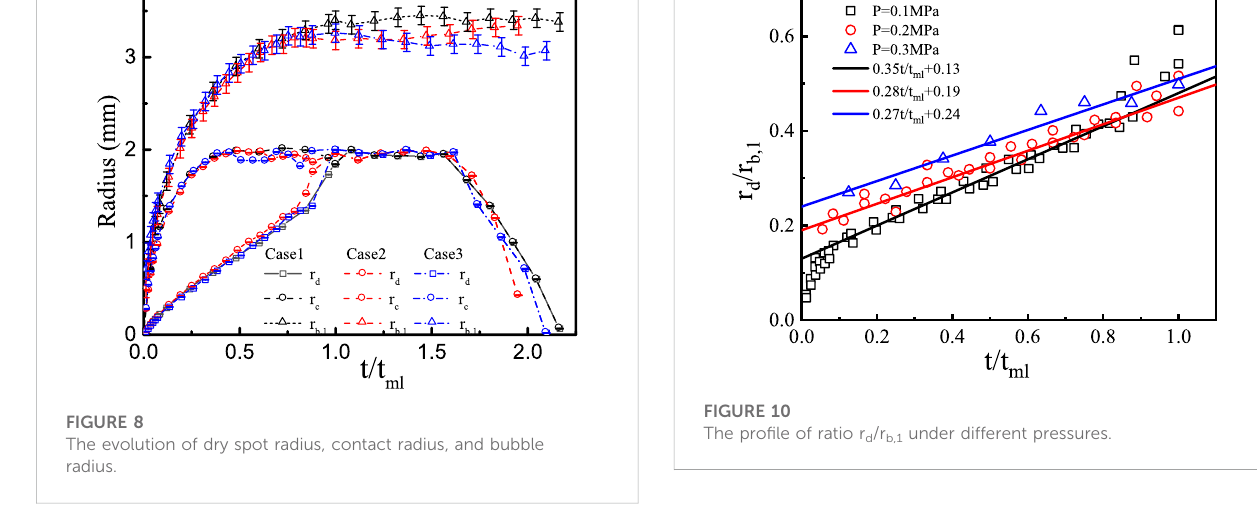
TABLE 2 Coef fi cients in correlations of the dry spot radius and the microlayer thickness. Pressure